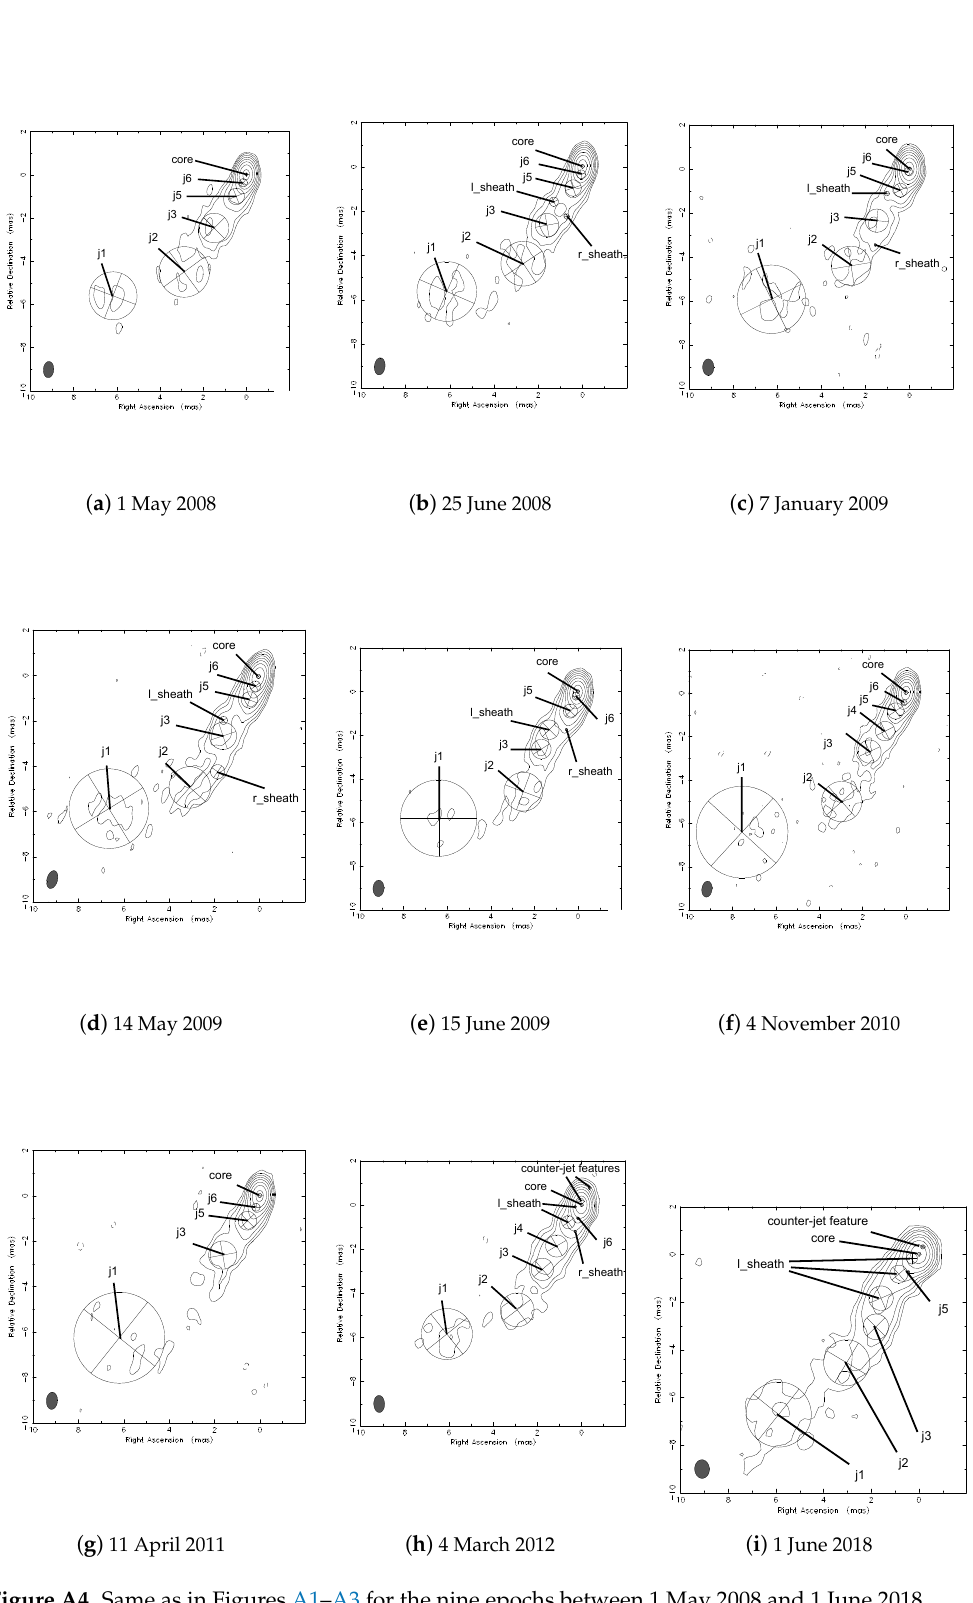
Figure A4. Same as in Figures A1–A3 for the nine epochs between 1 May 2008 and 1 June